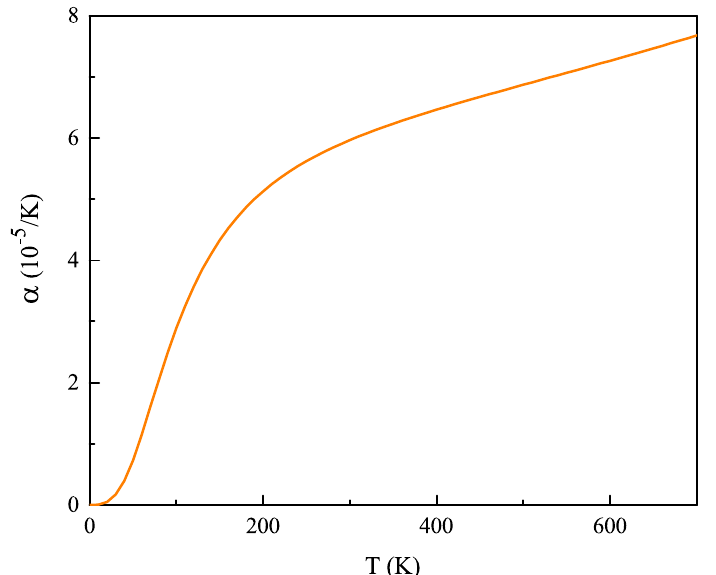
Figure 2. Thermal expansion coefficient as a function of temperature for bulk kesterite Cu 2 ZnGeS 4